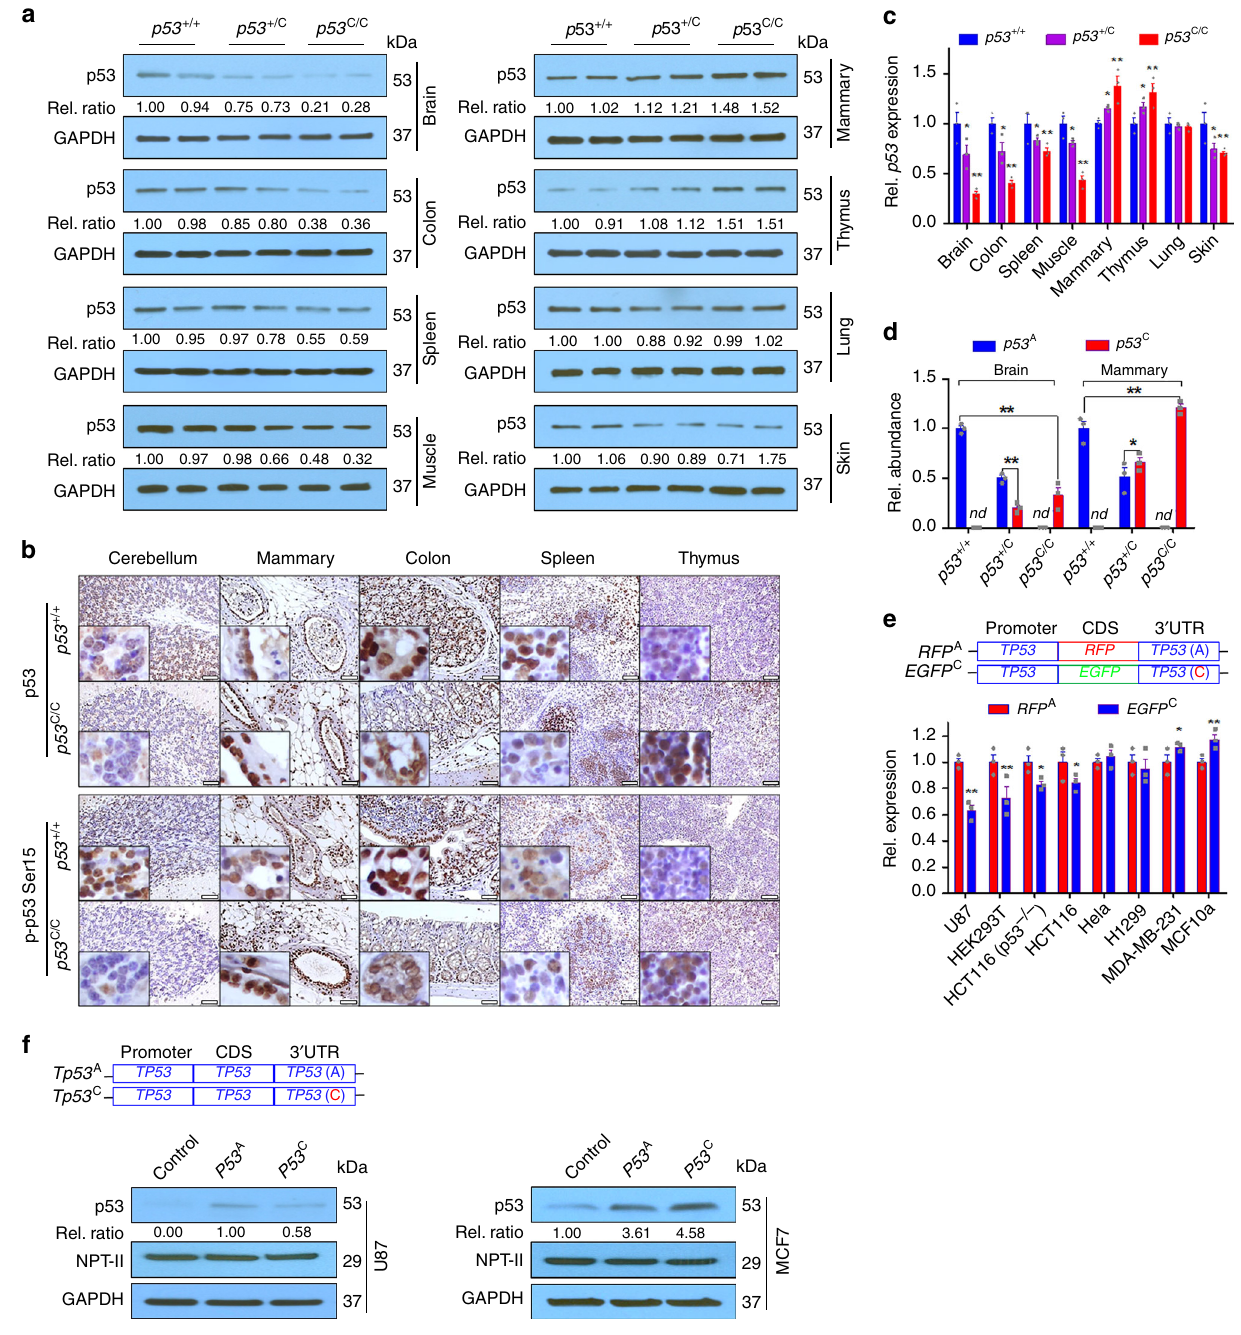
Fig. 3 Differential p53 deregulation by the p53 C allele in tissues and cell lines. a Western blotting analyses for p53 protein levels in tissues from mouse littermates. Each pair of lanes indicates samples from two different mice. Rel. ratio: the relative signal densities of p53 as referenced to that of GAPDH. b IHC staining for p53 (upper panel) and phosphorylated p53 at site Ser15 (lower panel) in p53 + / + and p53 C/C mice. Mice were treated with 4 Gy total body γ -irradiation, and the brain, mammary gland, colon, spleen, and thymus were collected 6 h later for IHC staining. Scale bar, 50 μ m. n = 3 mice per group, inserts show high-magni fi cation (×400) images. c Quantitative real-time PCR (qPCR) analysis for p53 mRNA levels in mouse tissues. Rel. p53 expression: Relative p53 mRNA levels normalized to Gapdh . The data were presented as mean ± s.e.m.; n = 3 independent biological replications. d Relative abundance (Rel. abundance) of A and C p53 cDNA alleles as determined by sequencing the PCR product of p53 cDNAs reverse transcribed from total mRNAs extracted from the brain and mammary tissues of mouse littermates. nd not detectable. e qPCR analysis for EGFP/RFP mRNA levels from indicated cell lines transfected with EGFP C or RFP A , with neomycin phosphotransferase (NPT-II) as a reference, a gene carried by the vector. CDS, coding sequence. Rel. expression: Relative expression. The data were presented as mean ± s.e.m.; n = 3 biological triplicates for each cell line. c – e * P < 0.05, ** P < 0.01 (one-way ANOVA). Error bars depict s.e.m. f Western blotting analyses for p53 protein levels in MCF7 and U87 cells transfected with a plasmid expressing TP53 with a WT 3 ′ UTR ( TP53 A ) or a 3 ′ UTR with an alternative PAS ( TP53 C ). Rel. ratio: the relative signal densities of p53 as referenced to that of NPT-II. n = 3 biological triplicates for each cell line. a , f Source data from Western blotting are provided in a Source Data fi